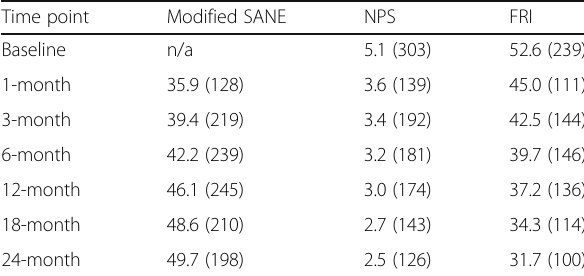
Table 2 Clinical outcomes for modified SANE, NPS and